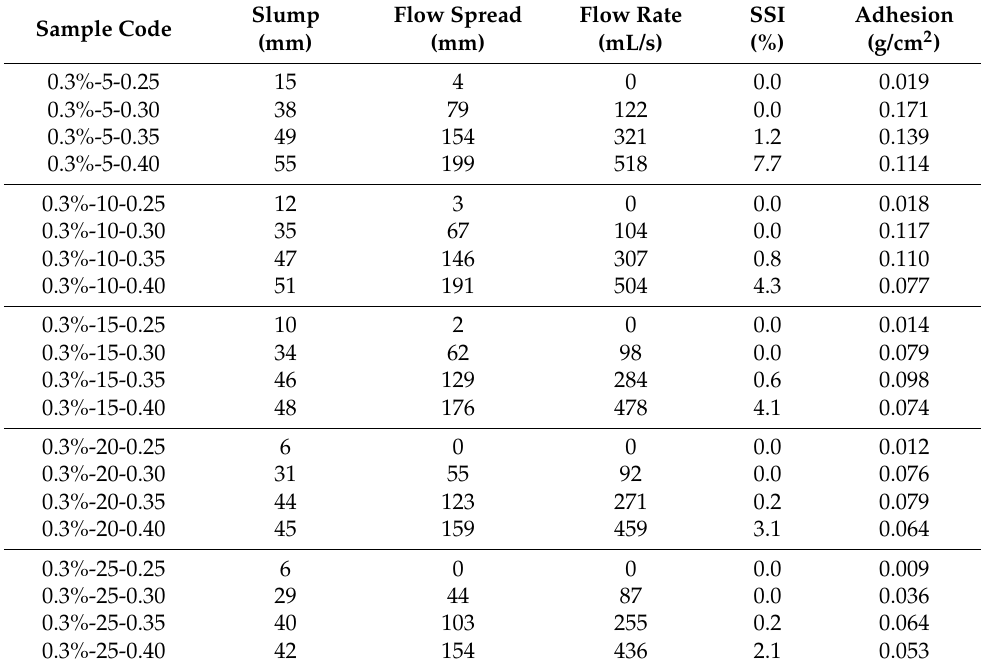
Table 4. Test results of mortar samples with fibre dosage = 0.3% and varying length.